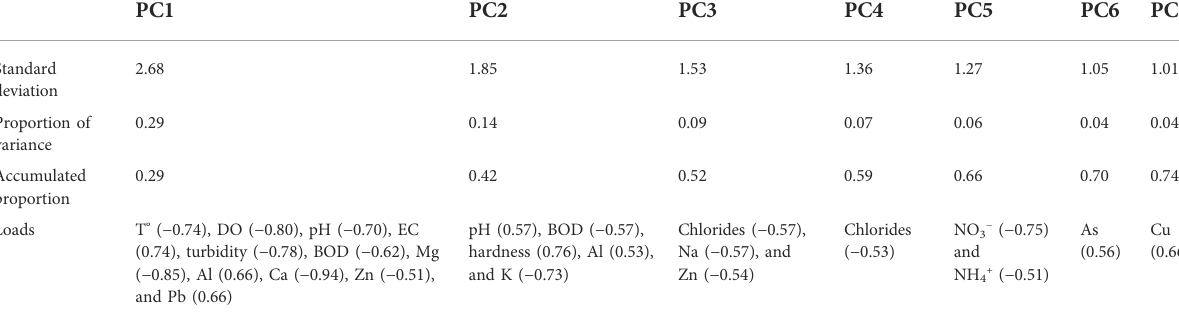
TABLE 3 Results of the principal component analysis of all parameters evaluated in the Lake